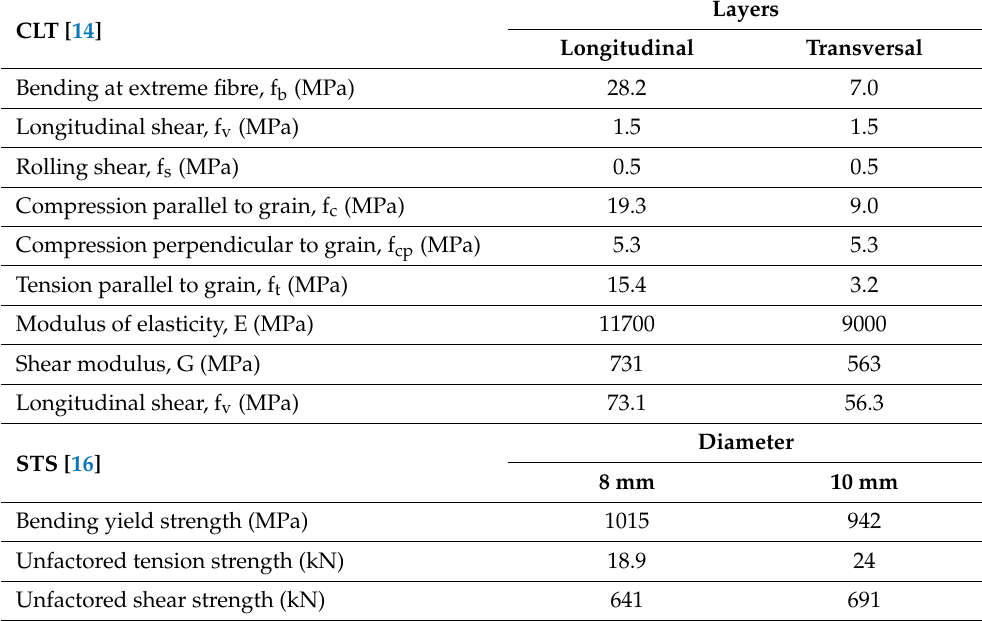
Table 1. Material